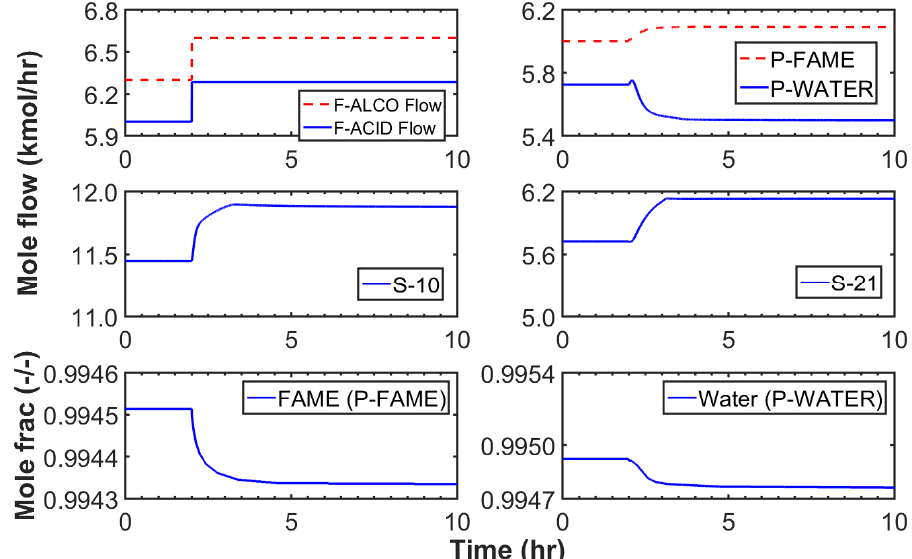
Figure 11. Stream results without cascade control scheme when the methanol feed flow was changed by +5%.